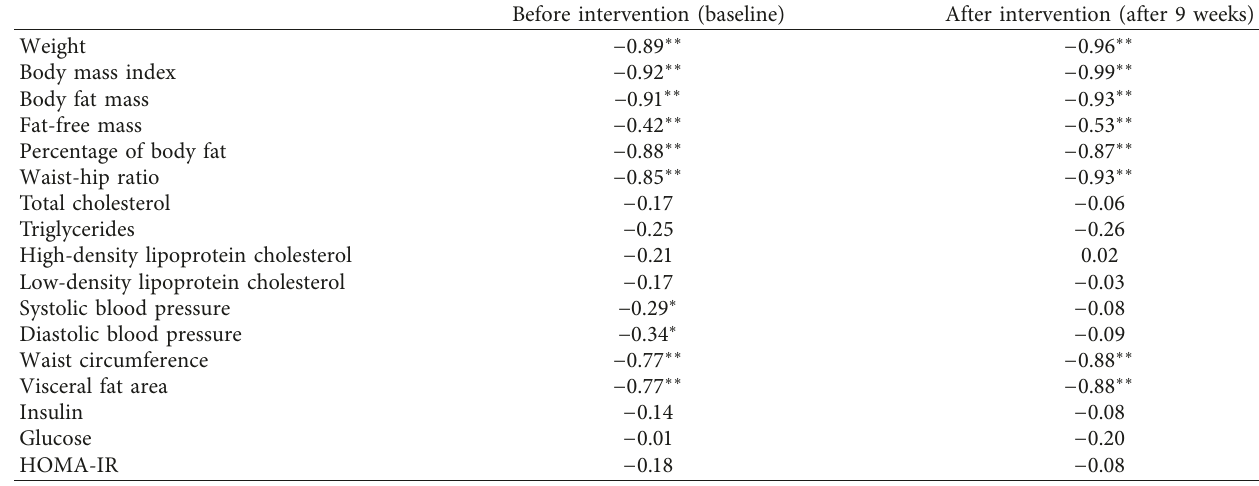
Table 6: Correlations between the serum levels of HMW adiponectin and anthropometric measurements and biochemical parameters before and after intervention ( N � 52). Before intervention (baseline) After intervention (after 9